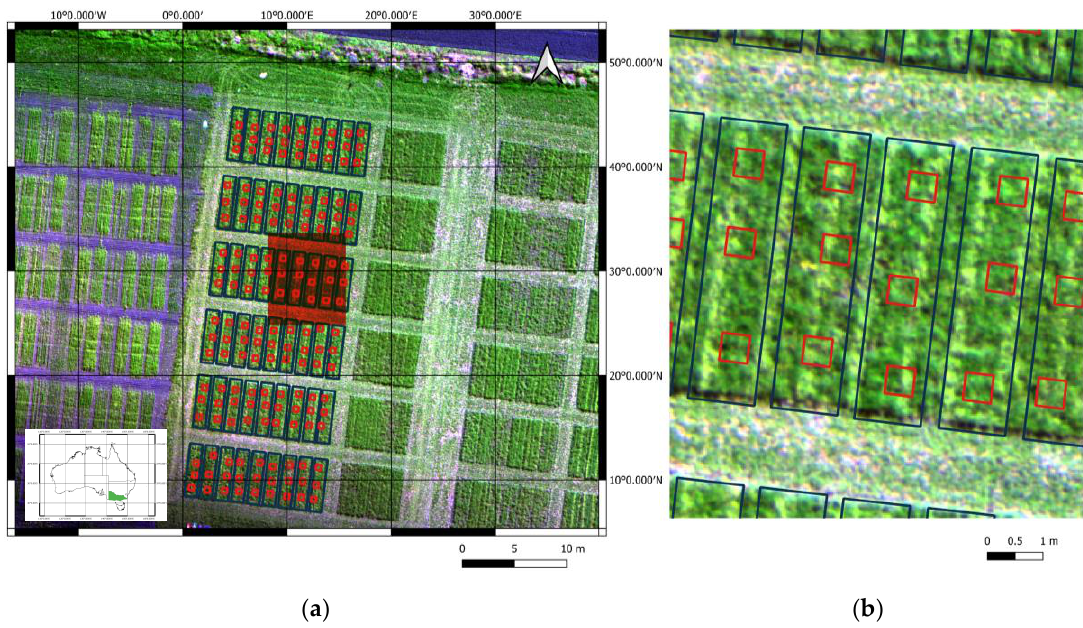
Figure 1. ( a ) Preharvest composite RGB orthomosaic of experimental site; ( b ) the expanded area of the study site (red transparent area of image “a”), where black color polygons represent the boundaries of the experimental plot and red color polygons represent the subsampling locations in each plot.